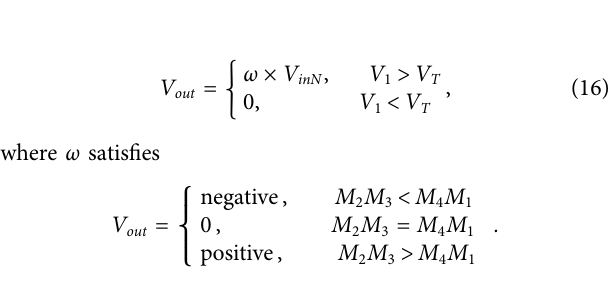
FIGURE 6 | The memristance M 1 comparison among the linear and non-linear memristor models with and without using improved simulated annealing